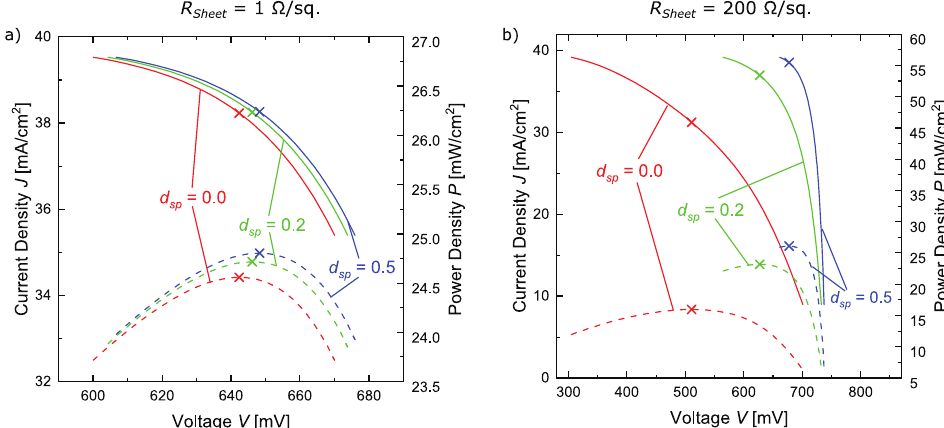
Fig. 3. I-V (compact line) and P-V (dashed line) curves around the maximum power point of HJT solar cells with sheet resistances of (a) 1 V /sq and (b) 200 V /sq for different positions of the voltage sense contact d sp using a contacting unit consisting of 12 current wires. The respective MPPs are depicted as